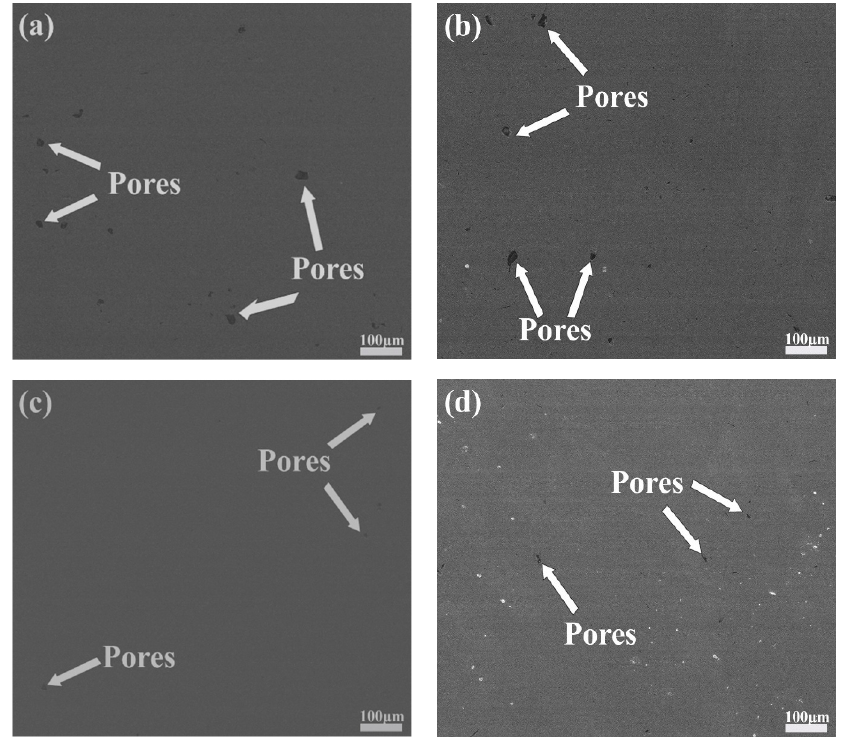
Figure 3. SEM images of ultrafine cemented carbides sintered at different temperatures for 40 min: ( a ) 1100 °C; ( b ) 1200 °C; ( c ) 1300 °C; ( d ) 1400 °C.